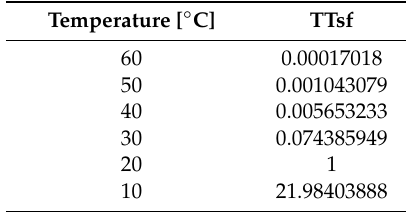
Table 10. TTsf for MASTIC-CR master curve at 20 °C.